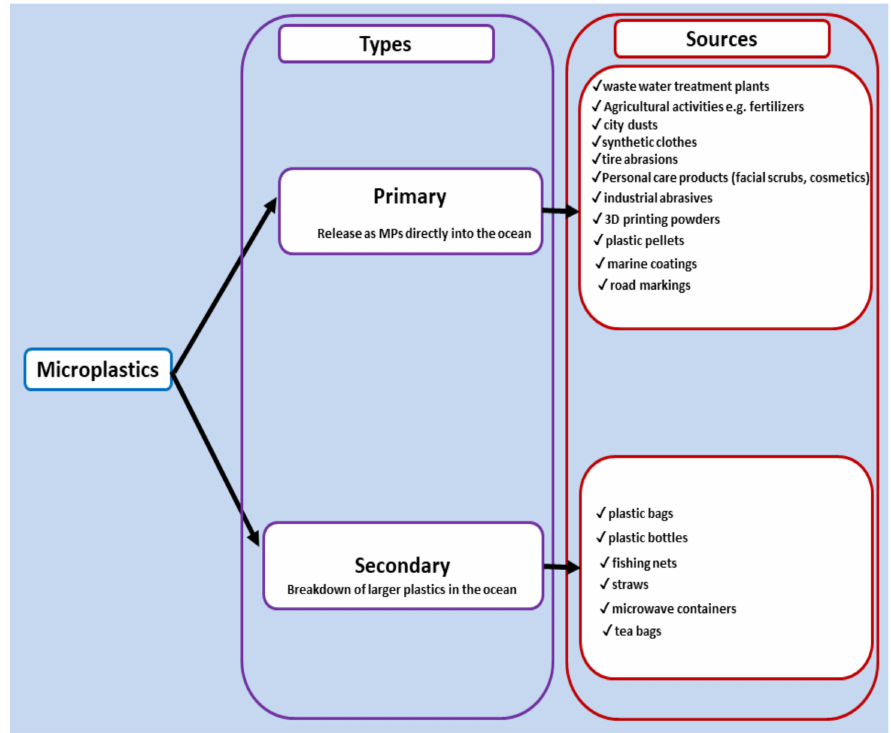
Figure 1. Types and sources of MPs pollution in the